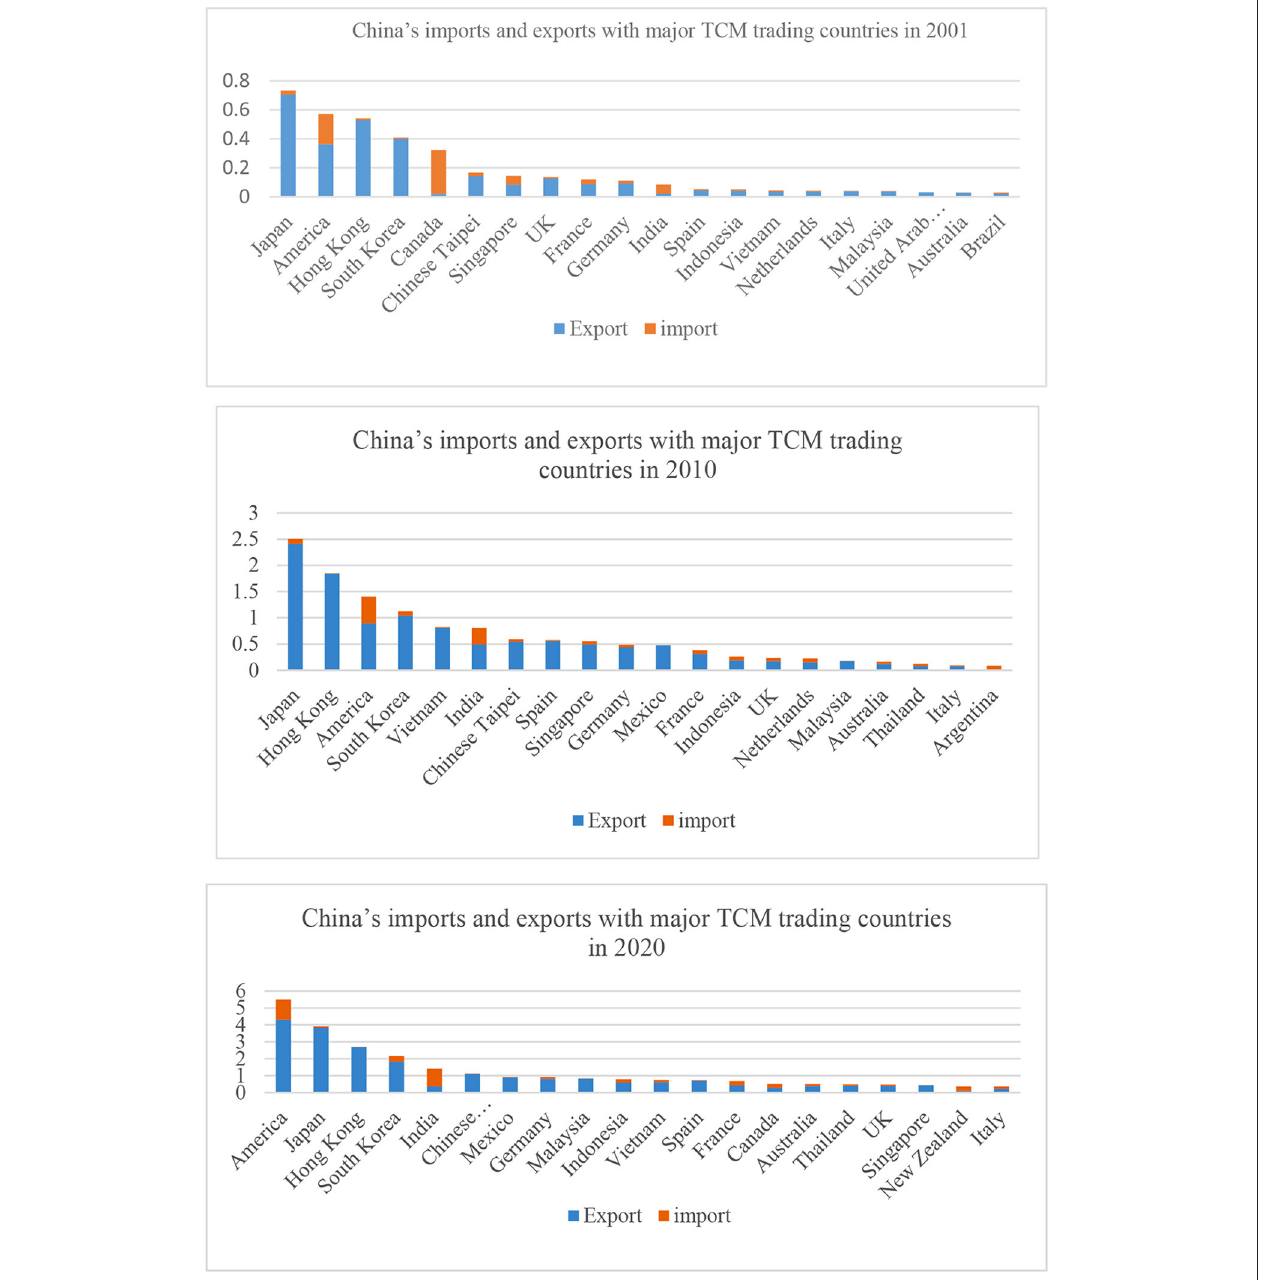
FIGURE 5 | China’s imports and exports in 2001, 2010, and 2020.